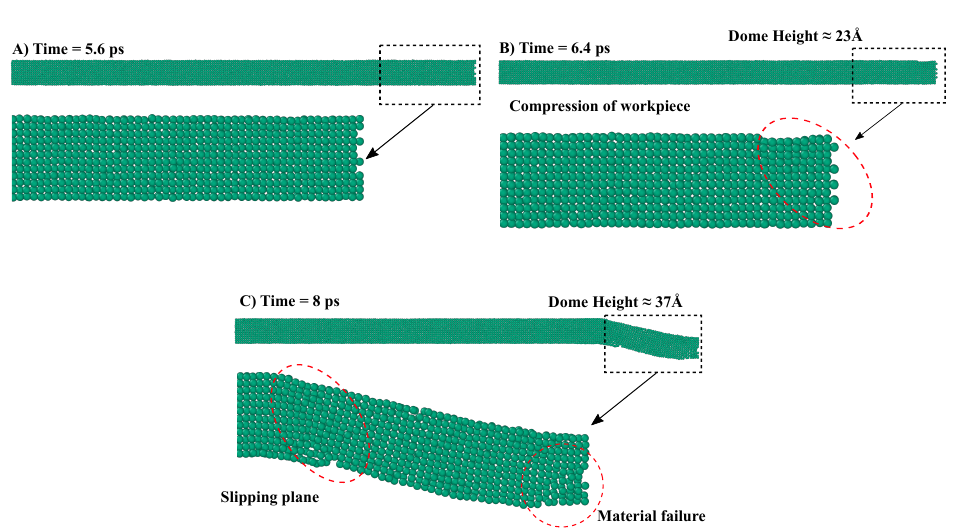
Figure 6. Different stages of loading at 8Å/ps. ( A ) shows the initial condition with detailed view, i.e., at Time = 5.6 ps. ( B ) shows the intermediate position of the workpiece with detailed view at Time = 6.4 ps, where the dome-height at this time is approximately 23 Å. ( C ) shows the position of workpiece just at the failure with detailed view, i.e., where the dome-height is approximately 37